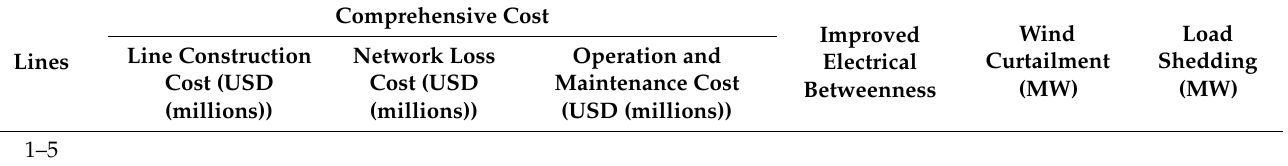
Table 8. TNEP scheme of B&B in modified IEEE RTS-24 bus system.